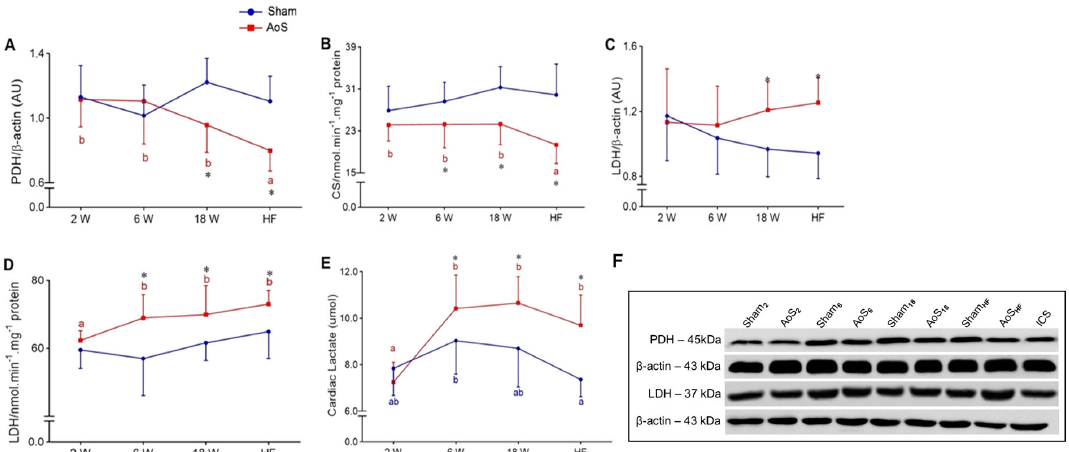
Figure 8. Myocardial aerobic and anaerobic metabolism at different euthanasia moments (2, 6, 18 weeks [W] and heart failure [HF]) evaluated by Western blot and enzymatic activity assay. Sham: operated control (blue); AoS: supravalvar aortic stenosis (red). Quantification of ( A ) PDH: pyruvate dehydrogenase, ( B ) CS: citrate synthase activity, ( C ) LDH: lactate dehydrogenase, ( D ) LDH: LDH activity, and ( E ) cardiac lactate concentration. ( F ) Representative bands of proteins. Data are expressed as mean ± SD and analyzed by ANOVA and Tukey. p < 0.05. * AoS vs. respective Sham. Distinct letters signify statistical difference between moments; ( n = 8 animals for each group).